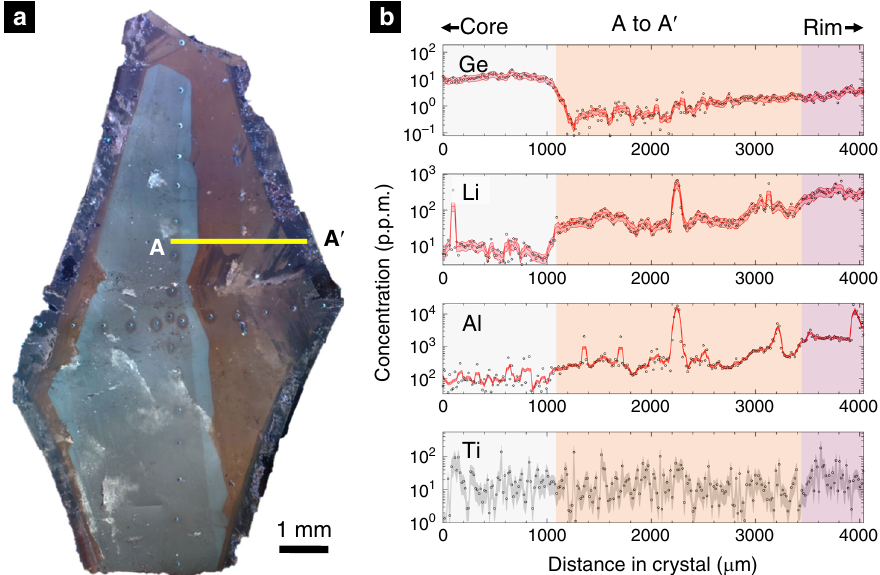
Fig. 2 Cathodoluminescence image of a quartz crystal and corresponding trace element transect. a Cathodoluminescence (CL) image of a quartz crystal from the Stewart pegmatite. Yellow line represents trace of geochemical transect. The plane of the crystal is part of {1000}. b Geochemical transect A – A ′ for Ge, Li, Al, and Ti in p.p.m. by weight. Dots represent data and red lines represent moving averages. Red envelopes represent standard error of the mean based on 3 σ of point analyses and a three-point moving average. Gray envelope in Ti represents 1 standard deviation to the data points. The error values are 26%, 28%, 8.5%, and 57% for Ge, Li, Al, and Ti, respectively. Background colors correspond with CL colors in a . Ti is scattered due to measurements being near detection